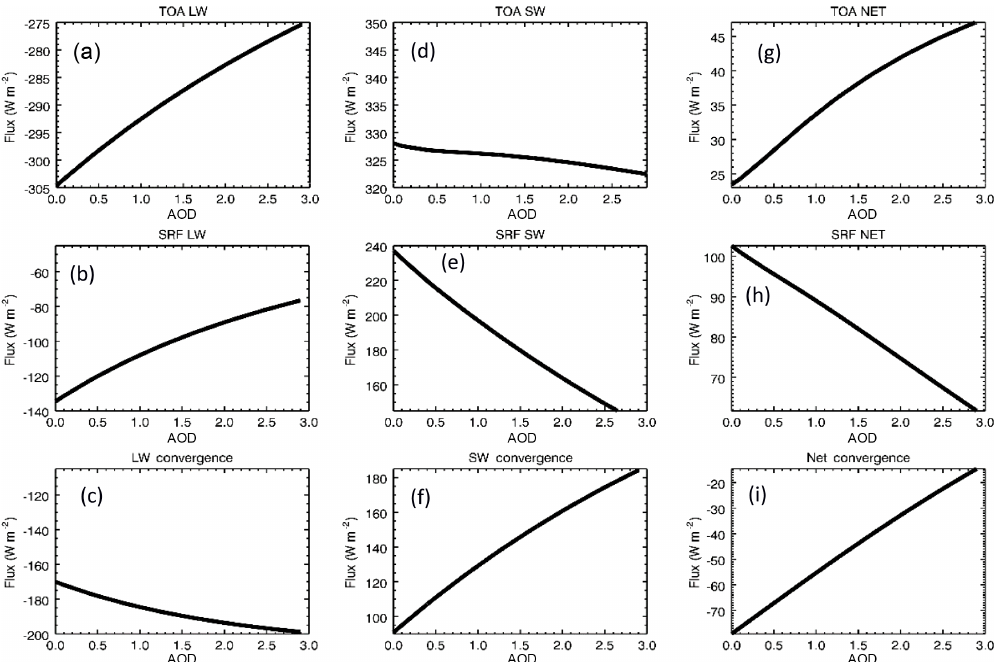
Figure 11. Radiative budget as a function of dust AOD. Top row: TOA longwave (a) , shortwave (b) , and net (c) . Second row: surface longwave (a) , shortwave (b) , and net (c) . Third row: atmospheric radiative convergence of longwave (g) , shortwave (g) , and net (i) .